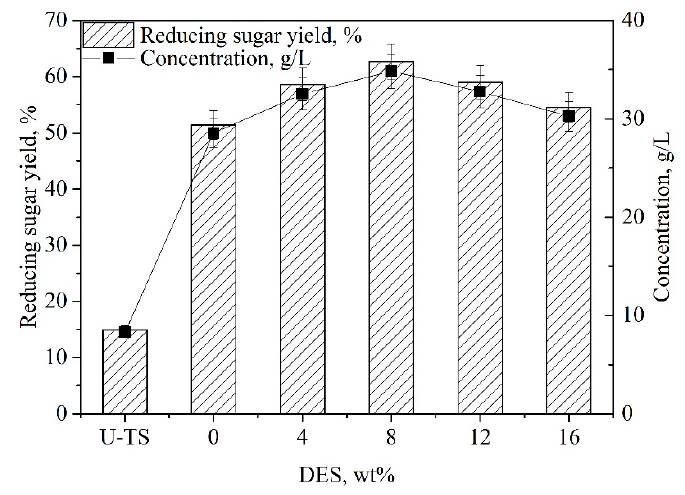
Figure 2. Effects of deep eutectic solvent (DES) concentration on the enzymatic saccharification of TS. [Pretreatment condition: NaOH (7 wt%)–ChCl:UA-TA (1 − 16 wt%), 75 °C, 60 min; Enzymatic hydrolysis condition: cellulase (10.0 FPU/g TS) and xylanase (30.0 CBU/g TS), 50 °C, pH 4.8]. [U-TS represents untreated TS].